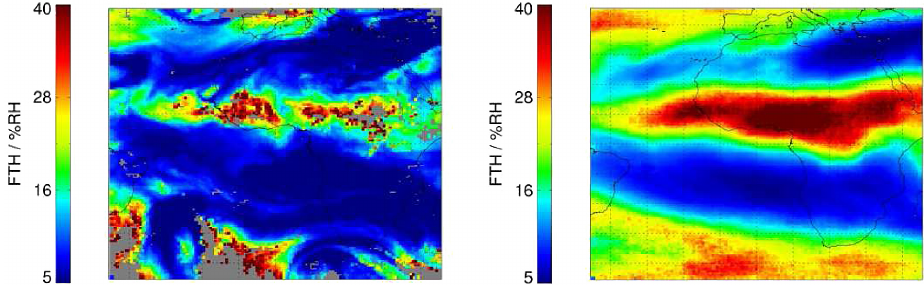
Figure 3. Instantaneous FTH at 12:00UTC on 15 July 2009 (left panel) and monthly averaged FTH for July 2009 (right panel). Undefined areas are in grey and they are usually associated with cloud-top pressures above